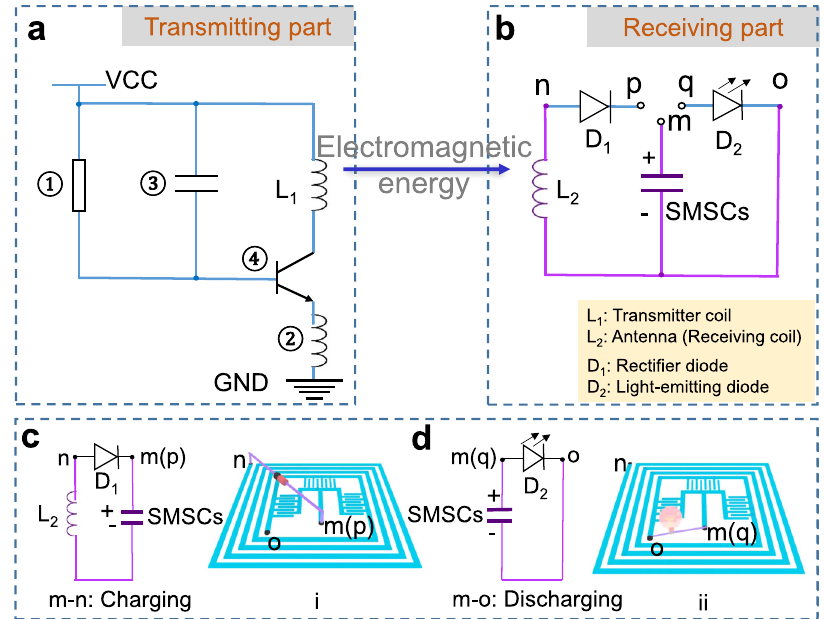
Fig. 4 Circuit diagram and working mechanism of the wireless charging system. a Circuit diagram of wireless transmitting part and ( b ) receiving part. c Schematics of the circuit while connecting points “ m ” and “ p ” of IWC-SMSCs to charge SMSCs (i). d Schematics of the circuit while connecting point “ m ” and “ q ” of IWC-SMSCs to release the accumulated charges in SMSCs (ii), thus lighting a red LED. The IWC-SMSCs are in purple color in the circuit